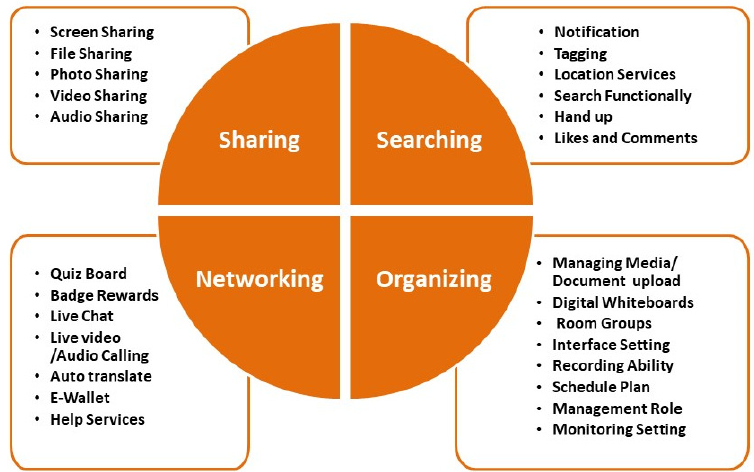
Figure 1. The four tool categories in e-learning platform.